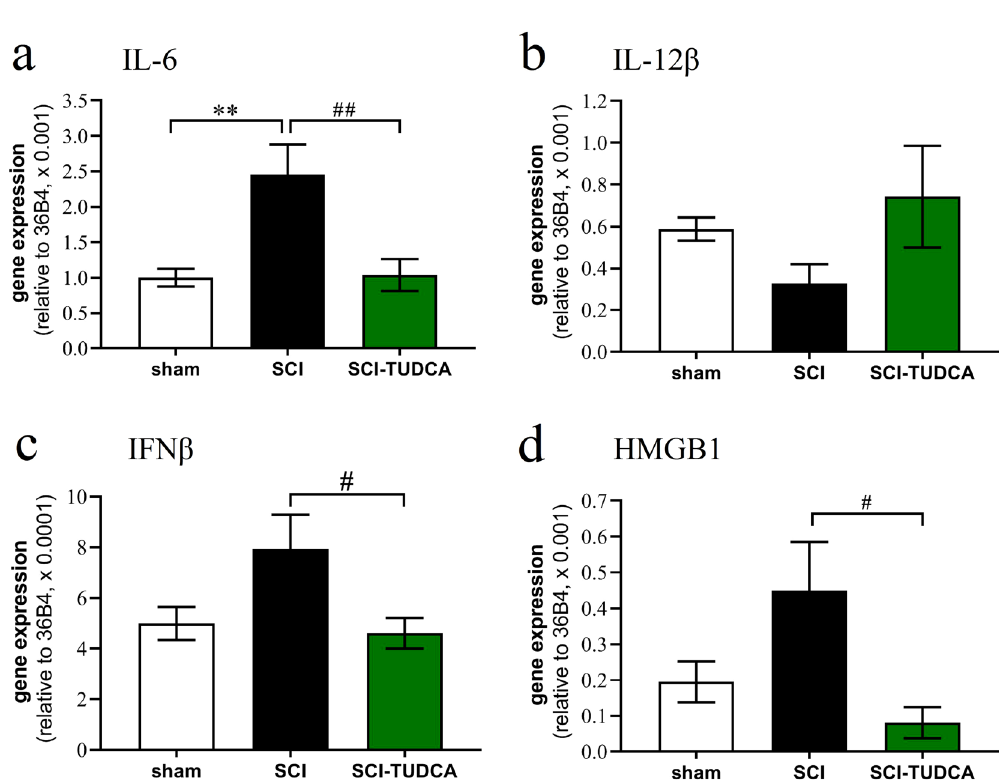
Figure 5. Treatment of SCI with TUDCA reduces expression of inflammatory genes. At 4 dpo, RNA extracts from spinal cord were analyzed with quantitative RT-PCR. ANOVA revealed significant treatment effects on the transcription of (a) IL-6 [F (2, 12) = 8.3, p < 0.01, (b) IL-12β [F (2, 12) = 1.6, n.s.]; (c) IFNβ [F (2, 12) = 3.9, p < 0.05], and (d) HMGB1 [F (2, 12) = 4.5, p < 0.05]; post hoc Dunnett’s tests: * comparison SCI vs. control; # SCI vs SCI-TUDCA; n = 5 rats). Treatments conditions are indicated as sham: laminectomy only; SCI: SCI with two i.p. injections of saline; SCI-TUDCA: SCI with two injections of 300 mg/kg TUDCA at the time of surgery and 24 h